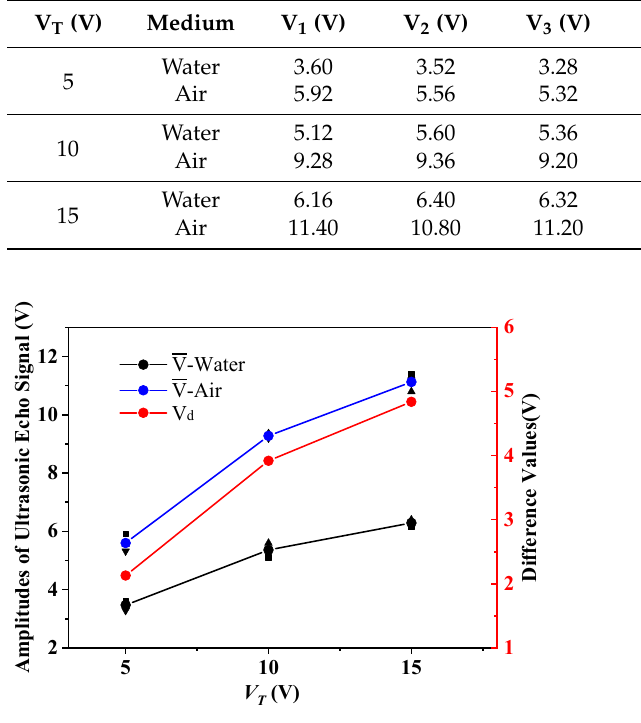
Figure 7. Results comparison diagram with different amplitudes.